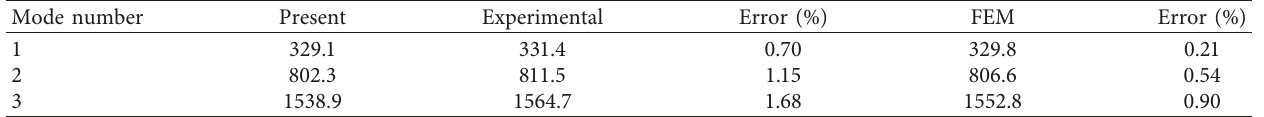
Table 7: Comparison of the natural frequencies for the isotropic